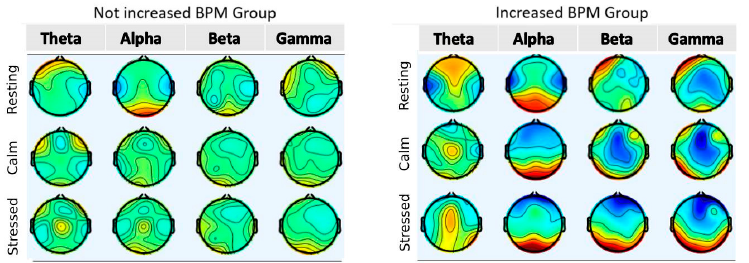
Figure 6. Brain heatmap comparison of subjects between the two groups for theta, alpha, beta, and gamma energy bands.